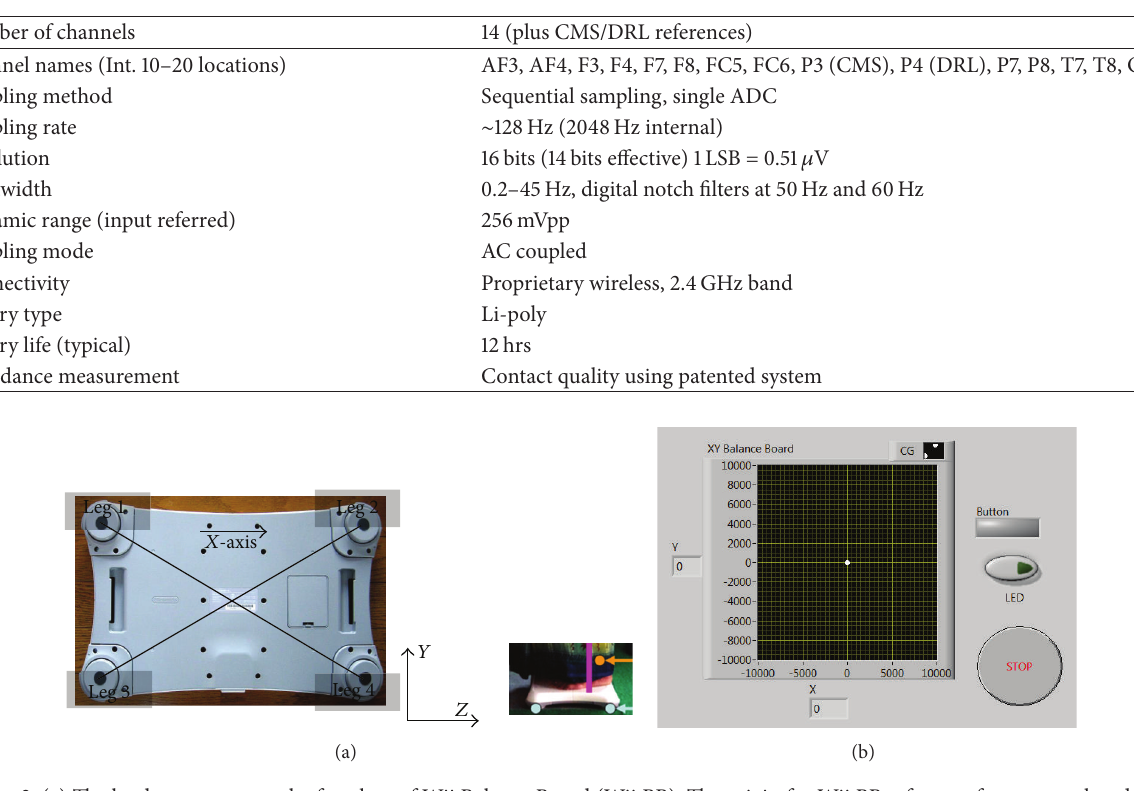
Figure 2: (a) The load sensors are at the four legs of Wii Balance Board (Wii BB). The origin for Wii BB reference frame was placed on the horizontal standing surface of Wii BB, which was taken at the centre of the four legs as illustrated by the intersection of the diagonals, and the 𝑋 -direction was assumed from the centre of leg 1 to the centre of leg 2, as shown. The 𝑌 -direction was upwards from the horizontal standing surface of Wii BB. (b) Real-time feedback of the center of pressure